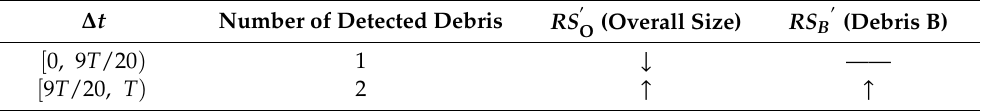
Table 2. Performance of two similar debris particles’ aliasing after CC .